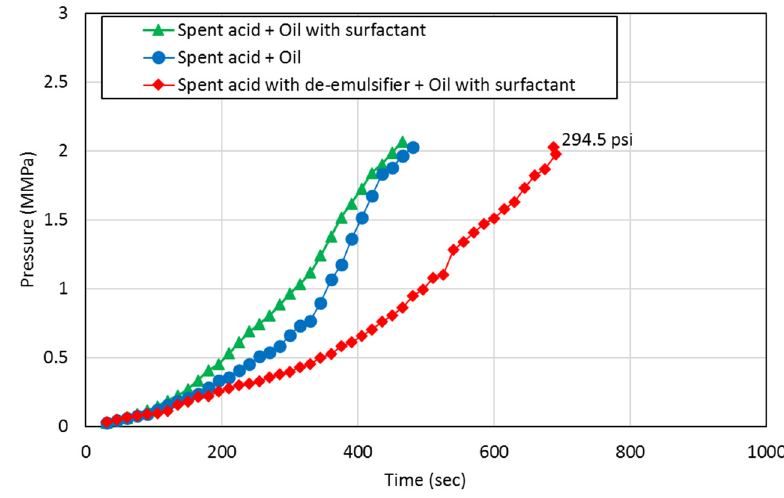
Figure 8. Pressure responses for the three scenarios when oil was injected from the outlet end of the core after spent-acid injection from the inlet side was completed.